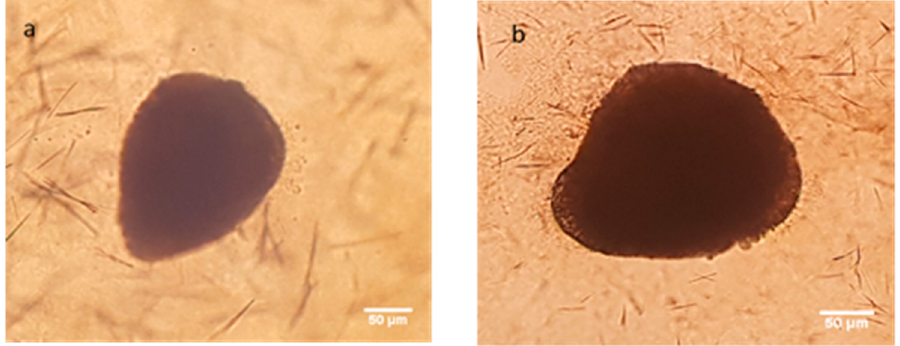
Figure 13. PCX loaded 6OCapro β CD ( a ) and PC β CDC6 nanoparticles ( b ) on MCF-7: HDF spheroids. PCX needle-like crystals observed in both photomicrographs.